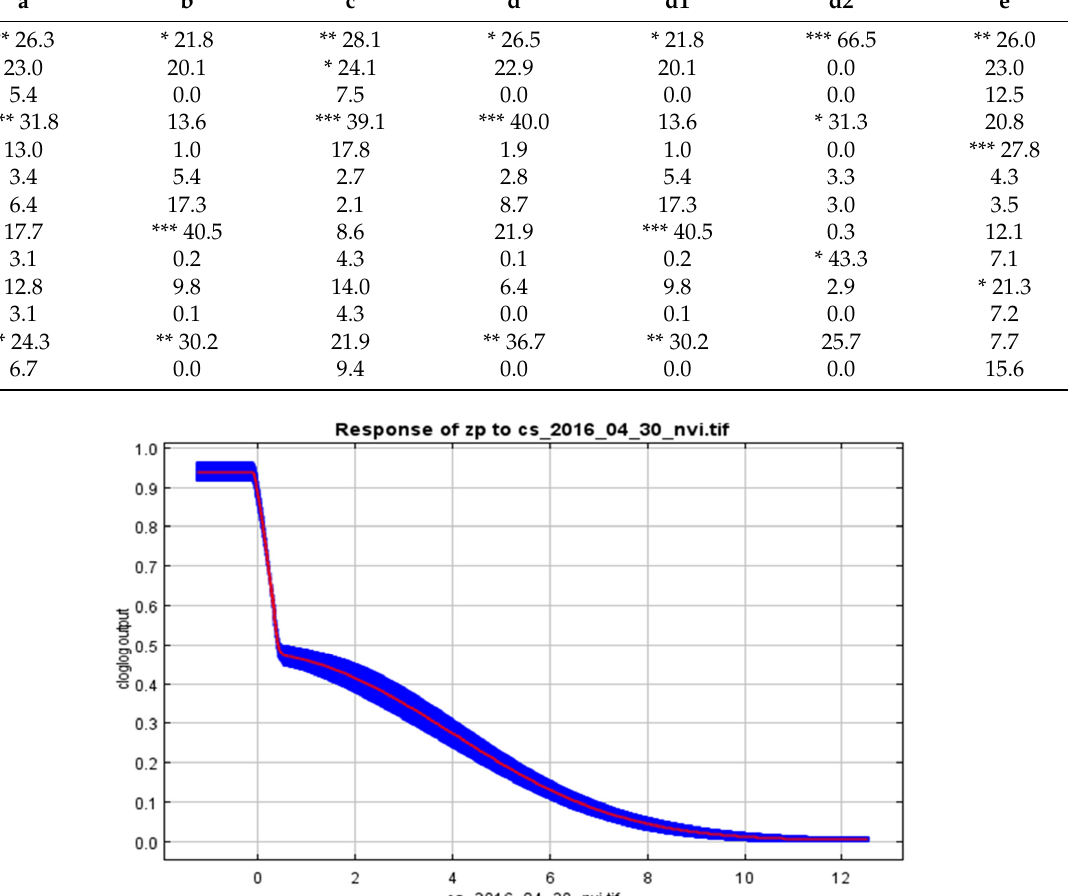
Figure 8. Dependence of probability of identifying waterlogged areas on the values of the NVI index. Case 1—site 1, spring 2016, contribution to variability—54.8%.